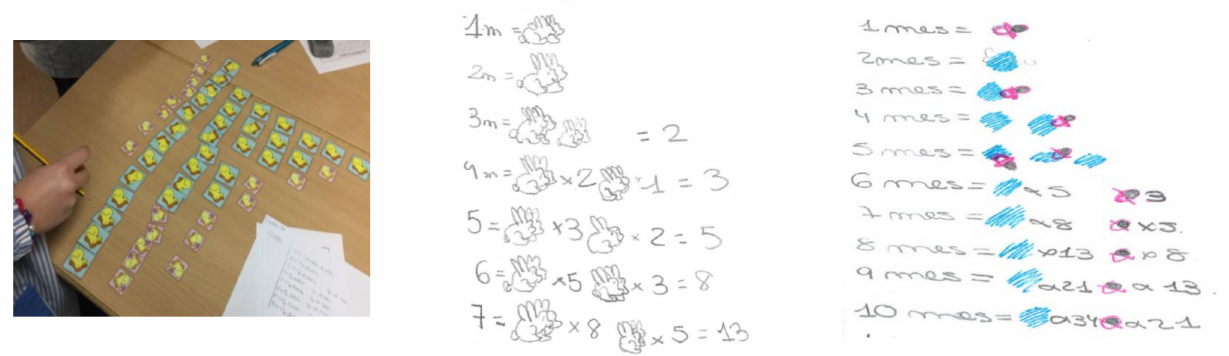
Figure 5. Examples of representations used.